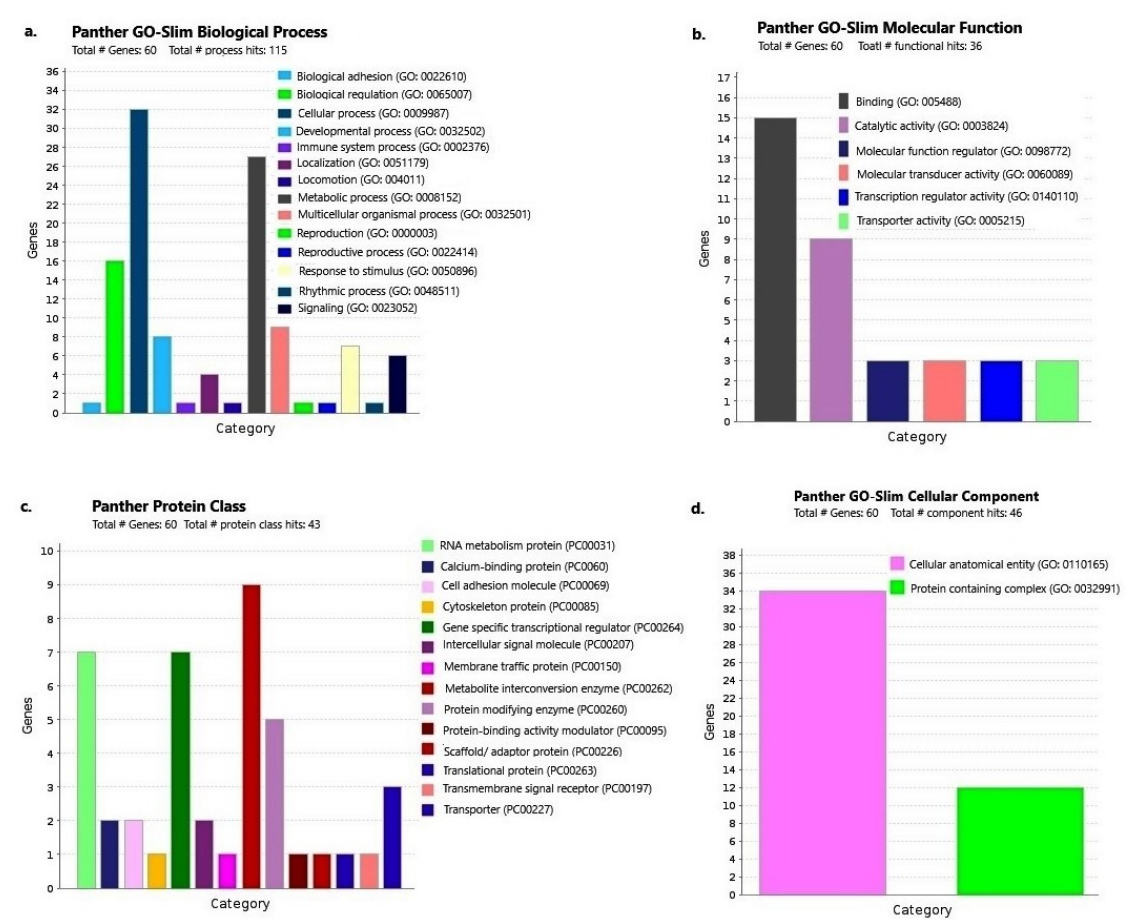
Figure 3. Panther database analysis showing GO terms associated with: ( a ) biological process, ( b ) cellular component, ( c ) molecular function and, ( d ) protein class of 36 studied clones.